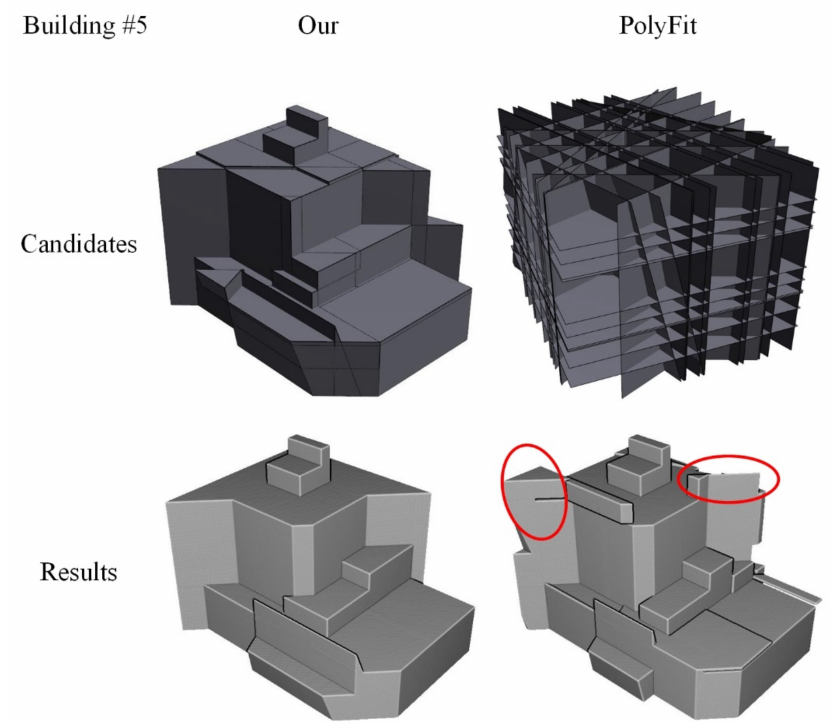
Figure 11. Comparison of candidate faces and resulting models generated by the proposed method and PolyFit [10] for Building #5.